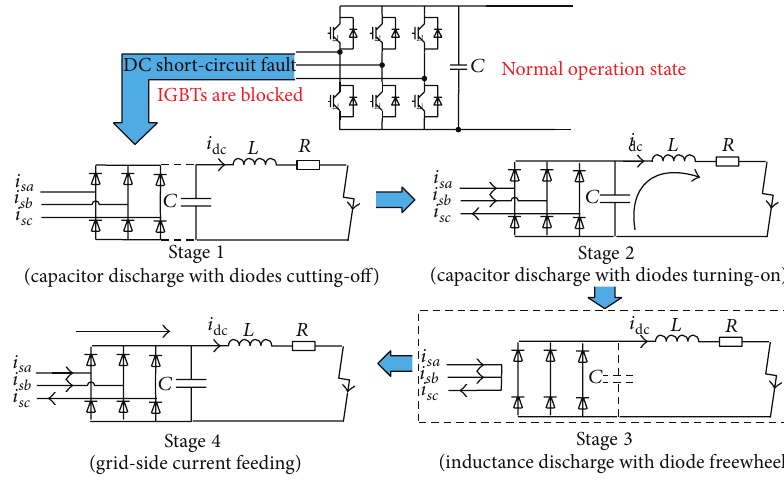
Figure 4: The four transient stages for the rectifier during DC short-circuit fault.